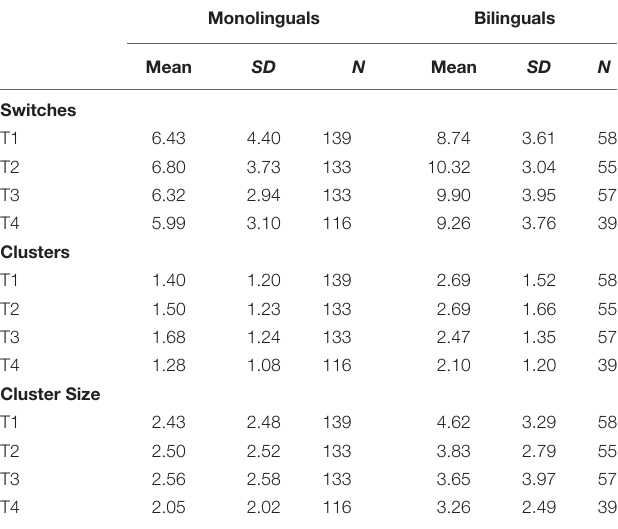
TABLE 2 | Descriptive statistics for the dependent variables across monolingual and bilingual participants and test waves,